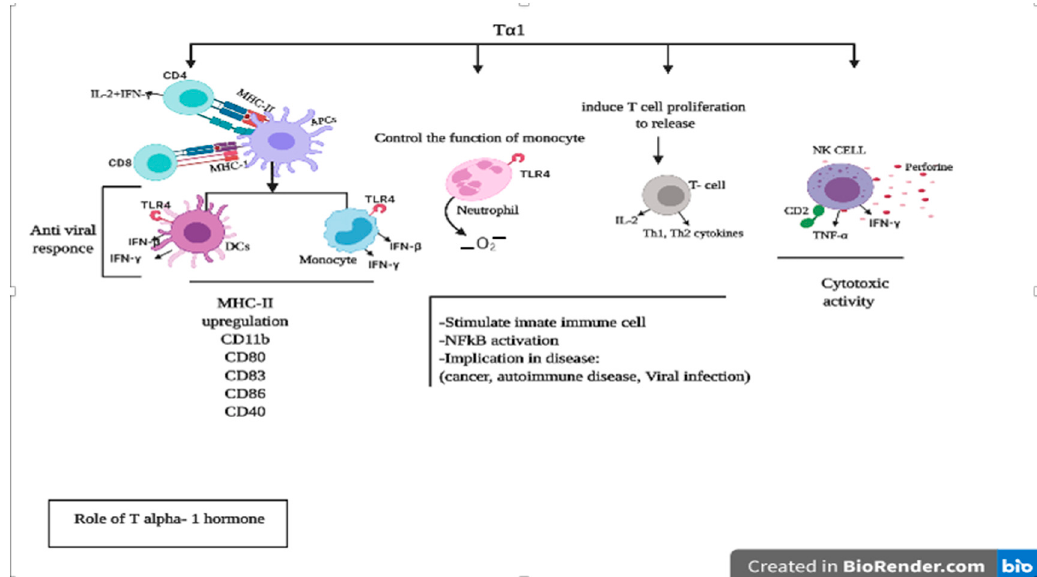
Figure 6. Effect of T α 1 on cells and pathways of the immune system. T α 1 can trigger multiple downstream pathways with distinct types of immune cells, pro/anti-inflammatory cytokine, and induce an immune response by Toll-like receptor (TLR) expression and cytokine production, leading to the initiation of a subsequent phase of immunity.